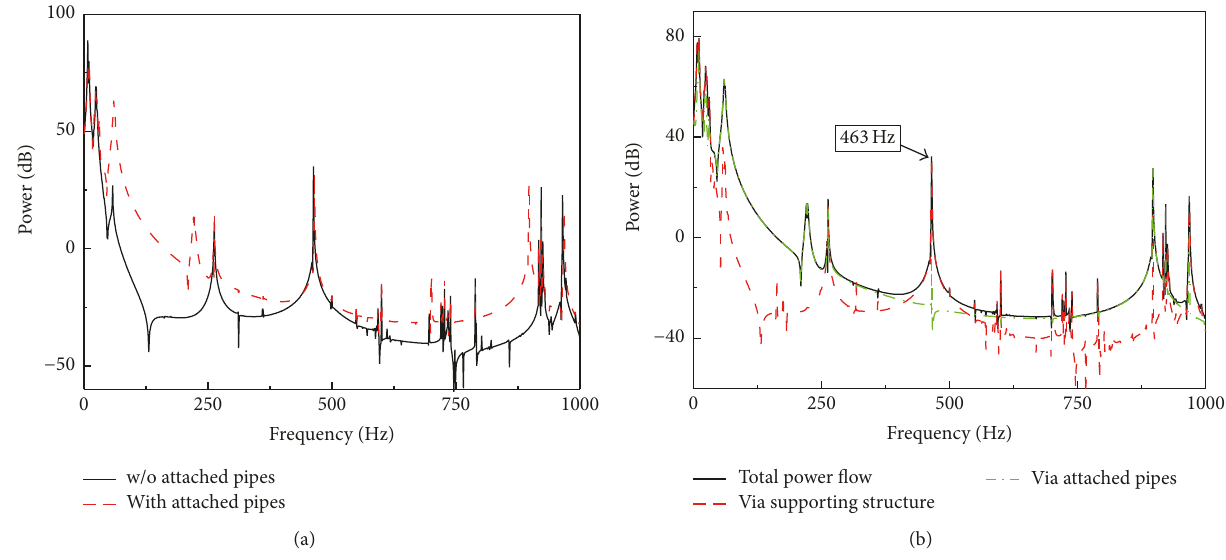
Figure 10: Effects of the attached pipes on power flow transmitted to the hull: (a) power flow with/without attached pipes; (b) power flow via different transmission